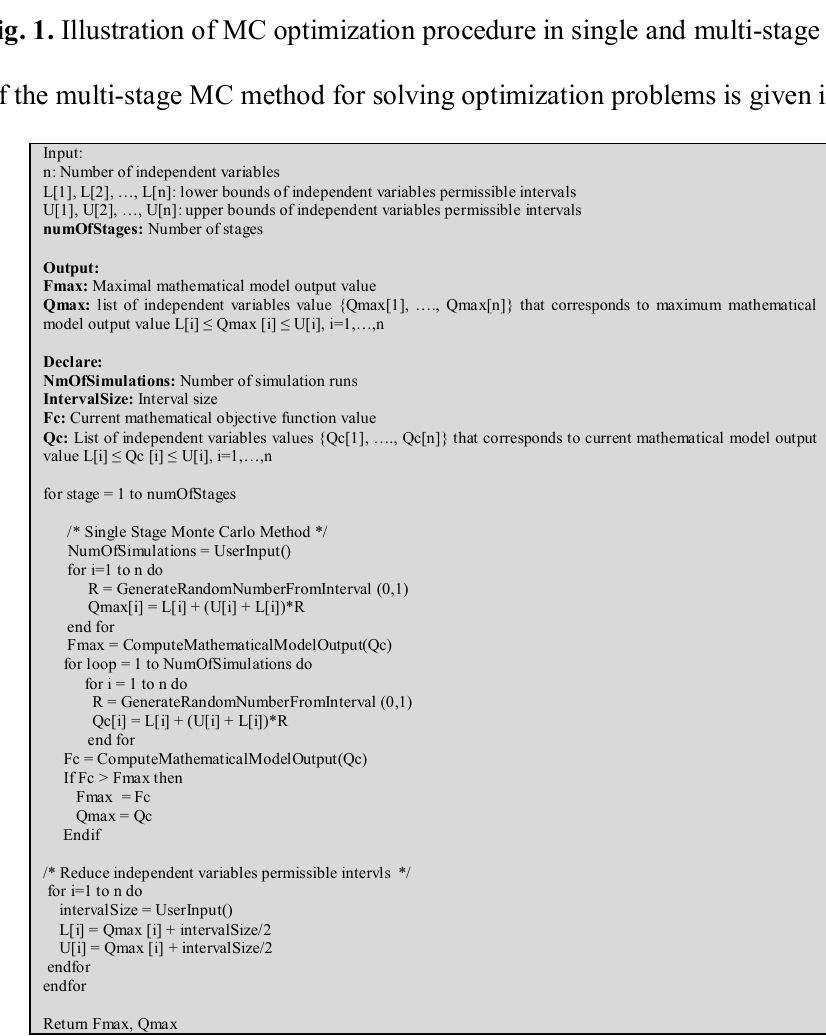
Fig. 2. Pseudo-code of the multi-stage MC method for solving optimization